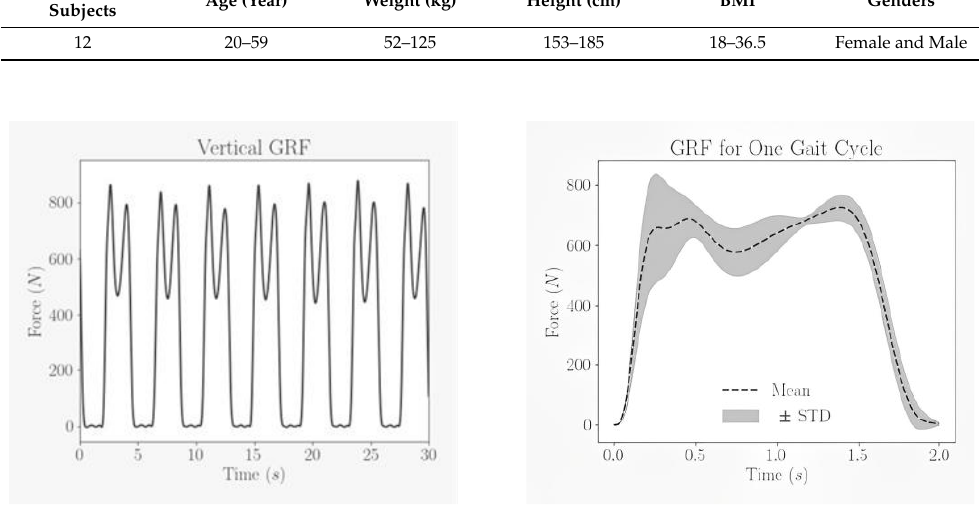
Each gait cycle was segmented from the whole trial, resampled to 512 data points and the mean and standard deviation plot of the segmented gait cycles from all the subjects and trials is shown in Figure 14. The dotted line represents the mean, and the shaded region represent the standard deviation from the mean.